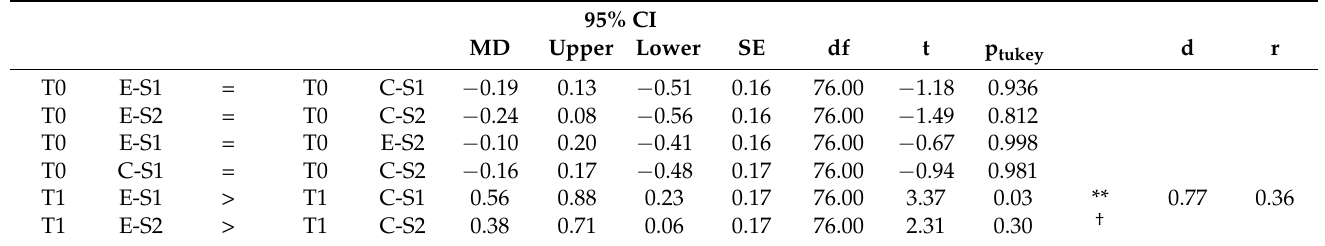
Table 4. Sample 1 and 2 post hoc comparison for PSQ score to test effect